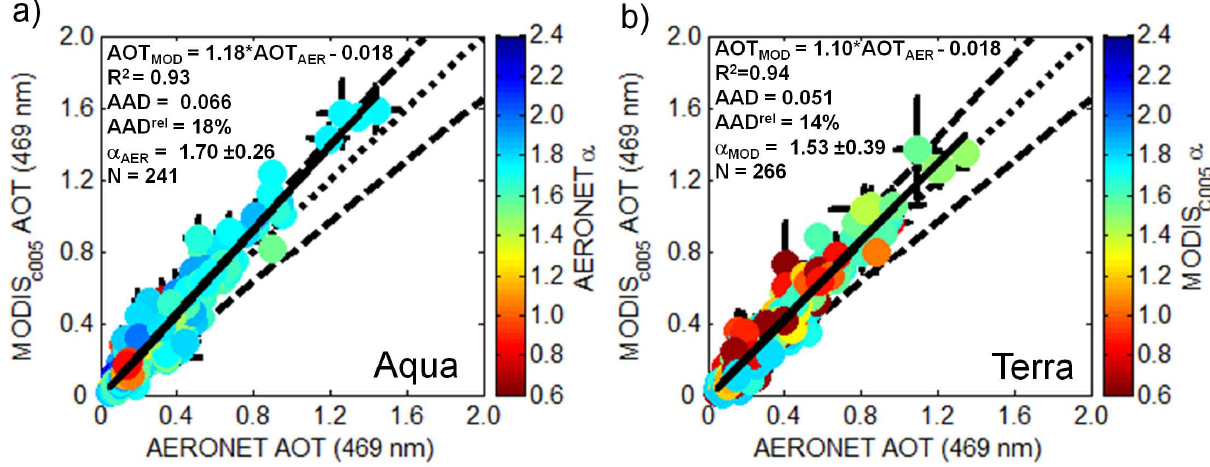
Fig. 4. Comparison between MODIS c005 and AERONET AOT at 469nm for overpasses of (a) Aqua and (b) Terra during the time periods investigated here. The color code refers to α as obtained with AERONET and MODIS for the wavelength pairs 440/675 and 469/645nm, respectively. The solid, dashed and dotted lines represent linear fits, expected uncertainties for one standard deviation of the MODIS c005 aerosol retrievals and 1-to-1 line, respectively. The median ˚Angstr¨om exponent ( α ) and corresponding one standard deviation are given. The explanation of abbreviations is given in Sect.